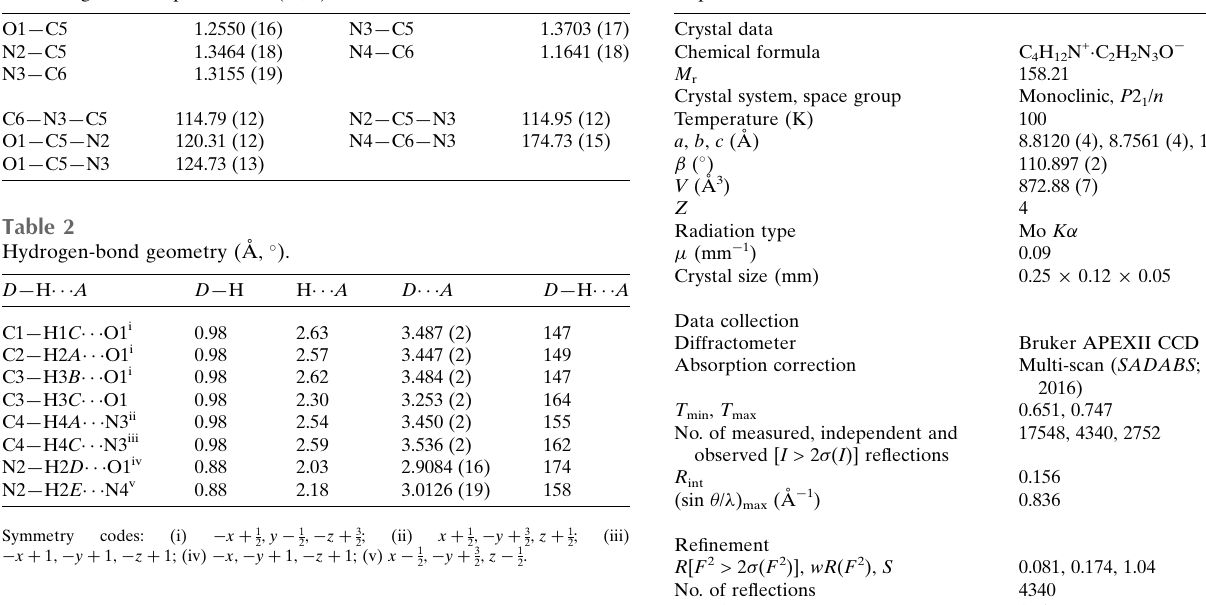
Table 1 Selected geometric parameters (A˚ , (cid:4) ).